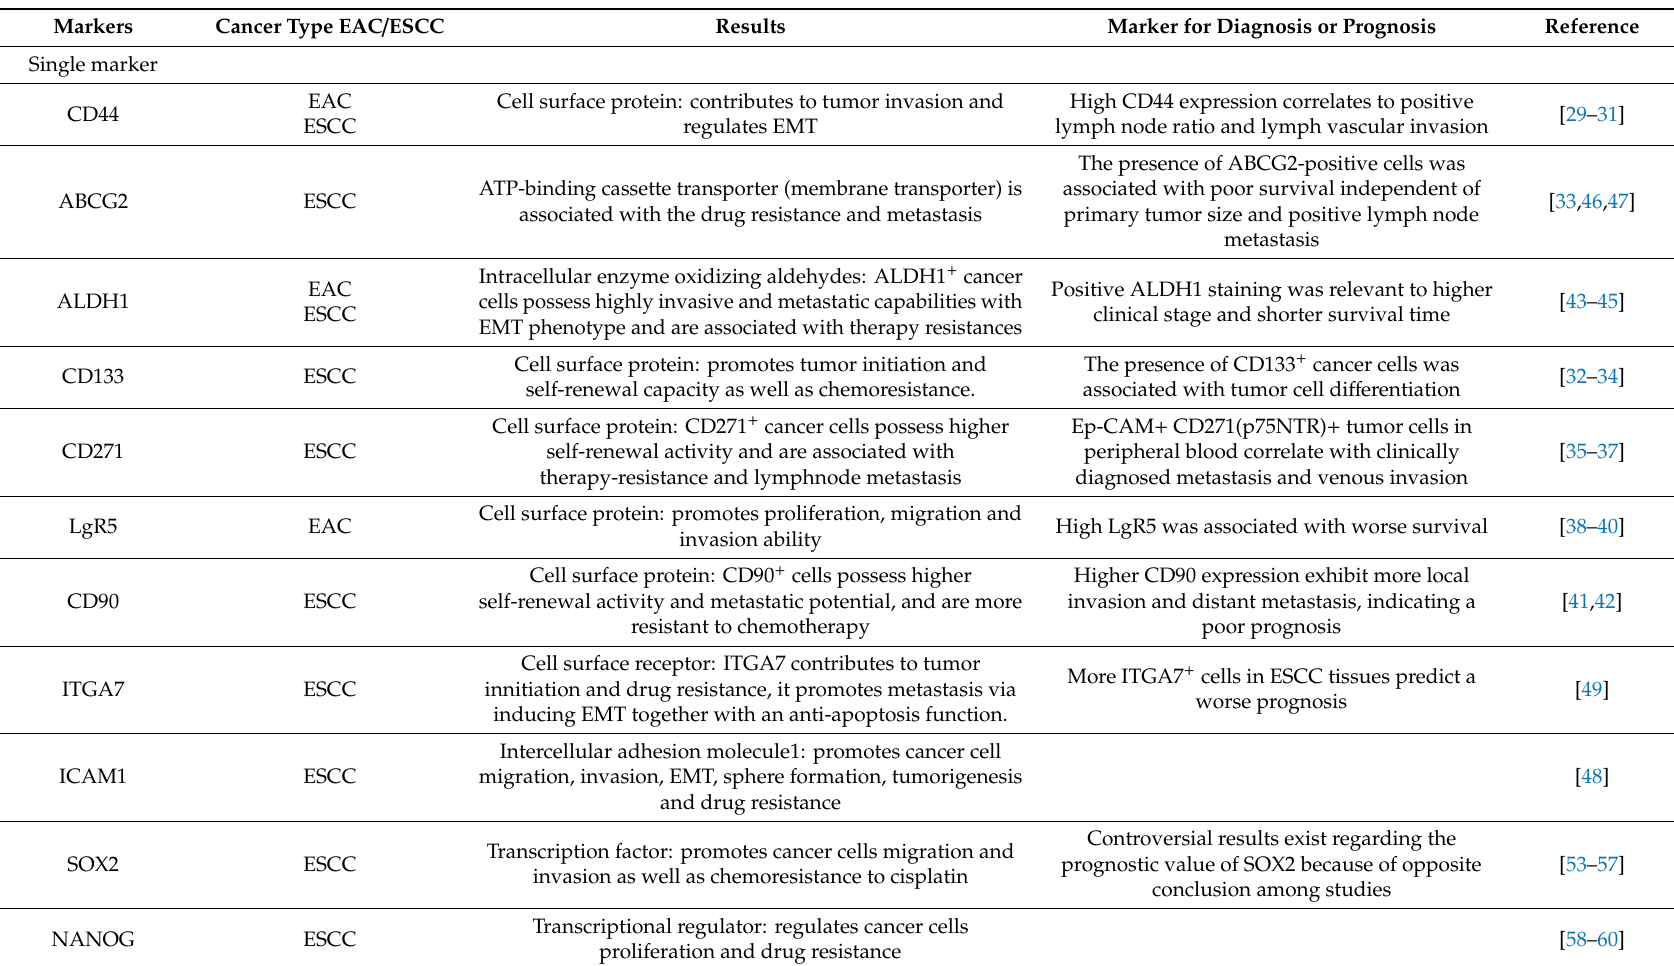
Table 1. Cancer stem cell markers for prognosis of esophageal